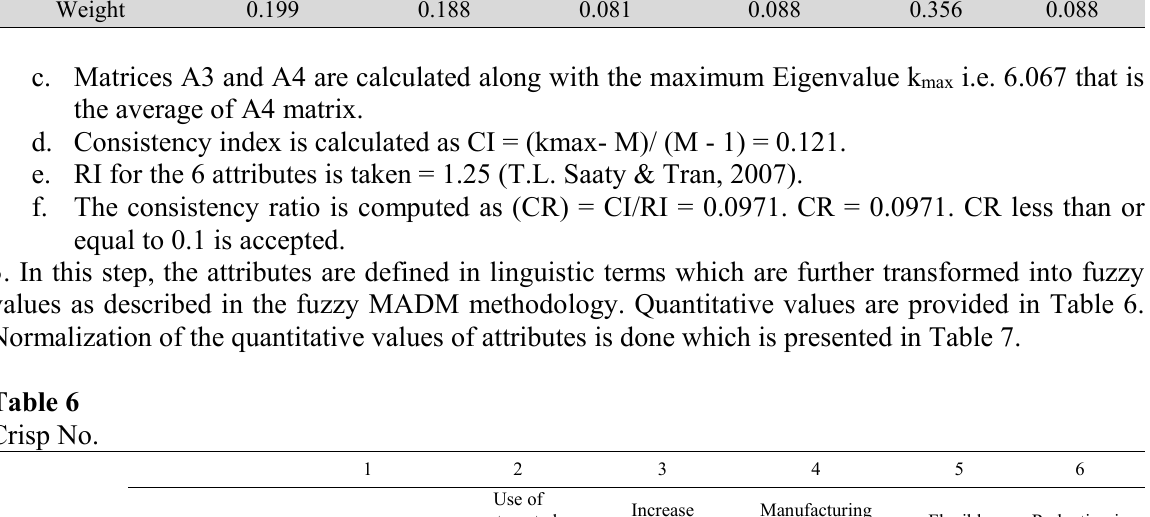
Weights of attributes Attributes